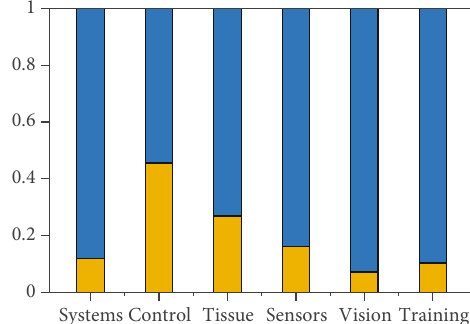
Figure 2: Relevance of each item within the total number of Scopus results related to remote ultrasound scan